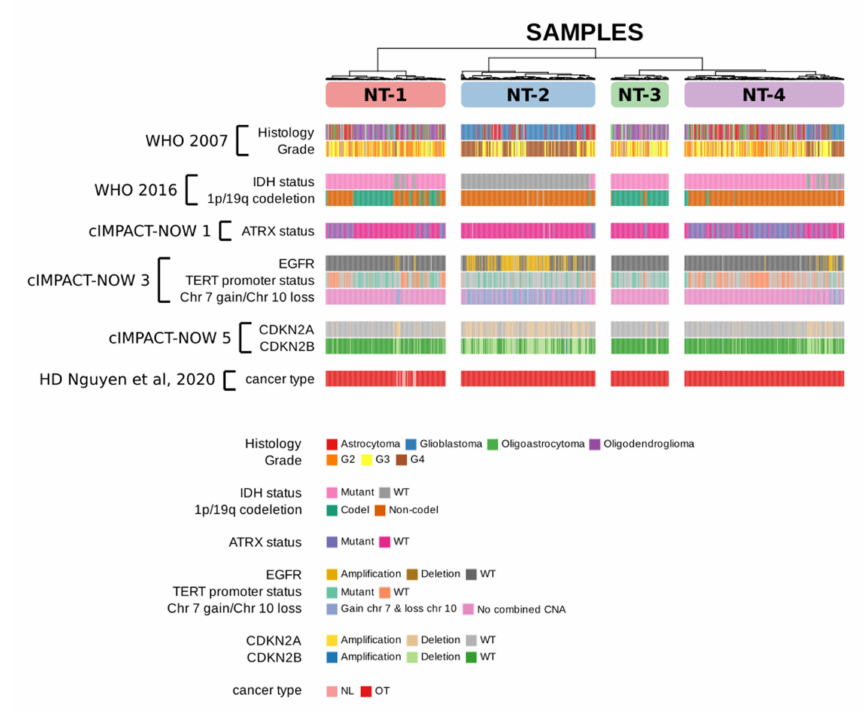
Figure 2. Distribution of frequent glioma molecular alterations within the four subgroups identified by GABA, glutamate and calcium gene expression-based unsupervised clustering. The molecular information for NT-1-4 gliomas was in accordance with the latest recommendations of the WHO classification of tumors of the central nervous